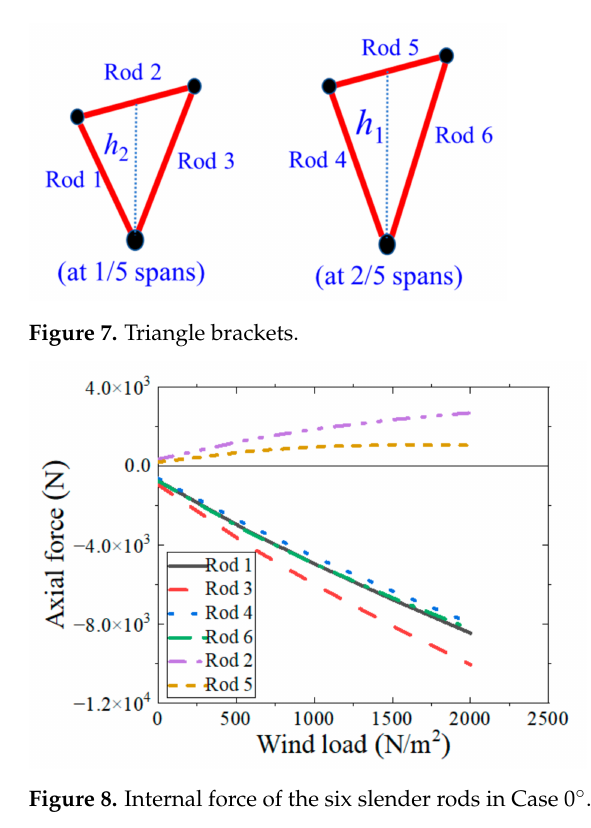
Figure 8. Internal force of the six slender rods in Case 0 ◦